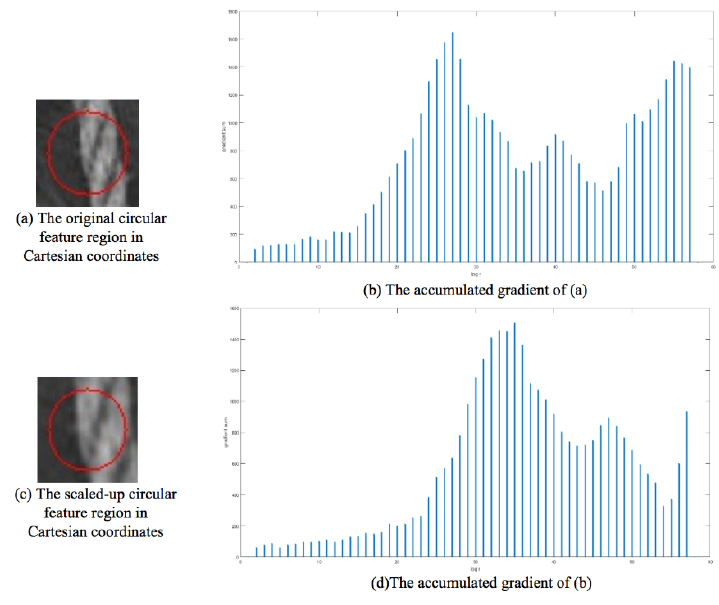
Figure 5. The accumulated gradients for the original and enlarged feature regions.